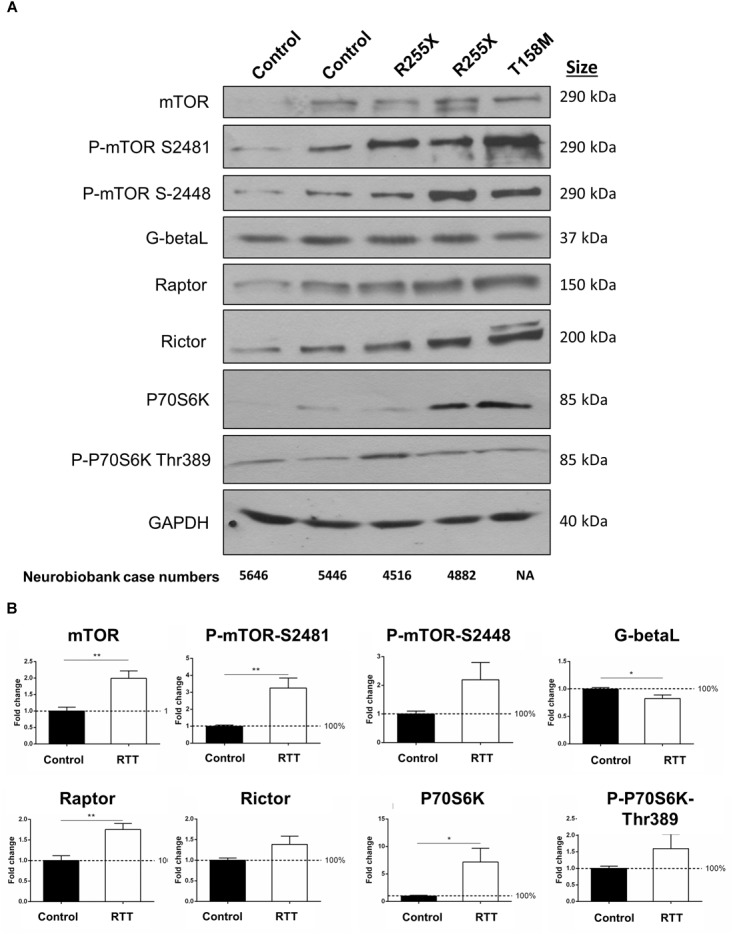
Total and phosphorylated mTOR and P70S6K in the cerebellum of RTT patients. (A) Representative Western blots (WB) form total cell extract of human control and RTT cerebellum with indicated antibodies (mTOR, phosphorylated mTOR at Serine 2481 or 2448, G-Beta-L as the common component of mTOR complexes, Raptor as part of mTORC1, and Rictor as part of mTORC2), P70S6K (and its phosphorylated form Thr389) and GAPDH. Molecular weight of each protein is indicated. NIH case numbers are indicated below the blots (NA, not applicable). (B) Quantification is reported from two to four WB repeats and average quantification of the corresponding blots from A and Supplementary Figure S4. Error bars represent standard error of the mean (SEM), N = 3 ± SEM for controls, N = 4 ± SEM for RTT patients. Statistical significance was determined by Welch’s t-tests with ∗p < 0.05, or ∗∗p < 0.01.